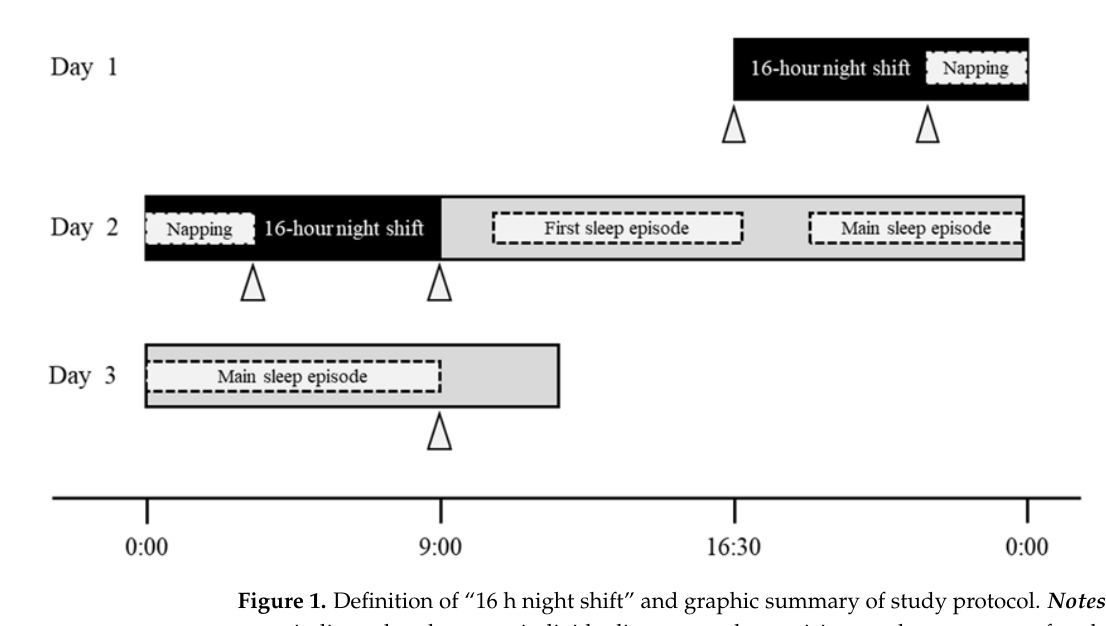
Figure 1. Definition of “16 h night shift” and graphic summary of study protocol. Notes : the dotted areas indicate that there was individuality among the participants; the gray areas after the night shift indicate non-working time; the participants were asked to wear the wearable device (MTN-220) for assessing participants’ sleep/ activity from before the night shift (Day 1) to the morning of the next day after the night shift (Day 3); triangles indicate the measurement time of fatigue by the “Jikaku-sho shirabe.”